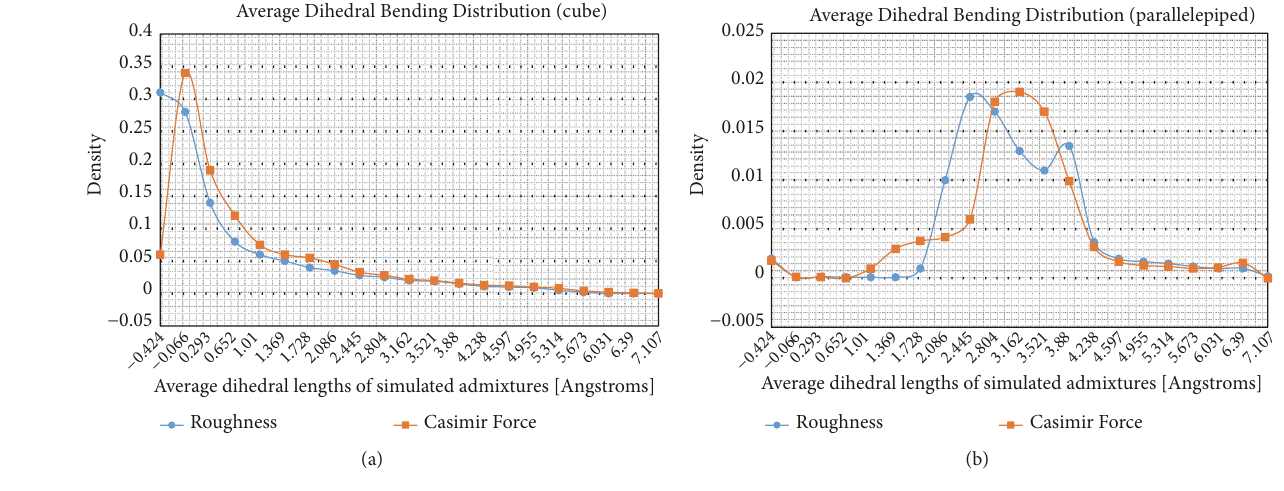
Figure 6: (a, b) Distribution of deviations of mean values of dihedral angles.